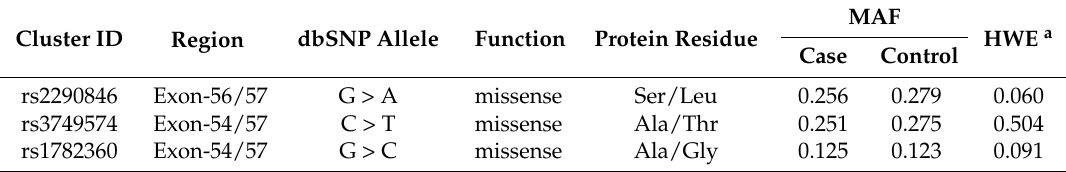
Table 2. Primary information of genotyped SNPs in lipopolysaccharide (LPS)-responsive beige-like anchor protein ( LRBA